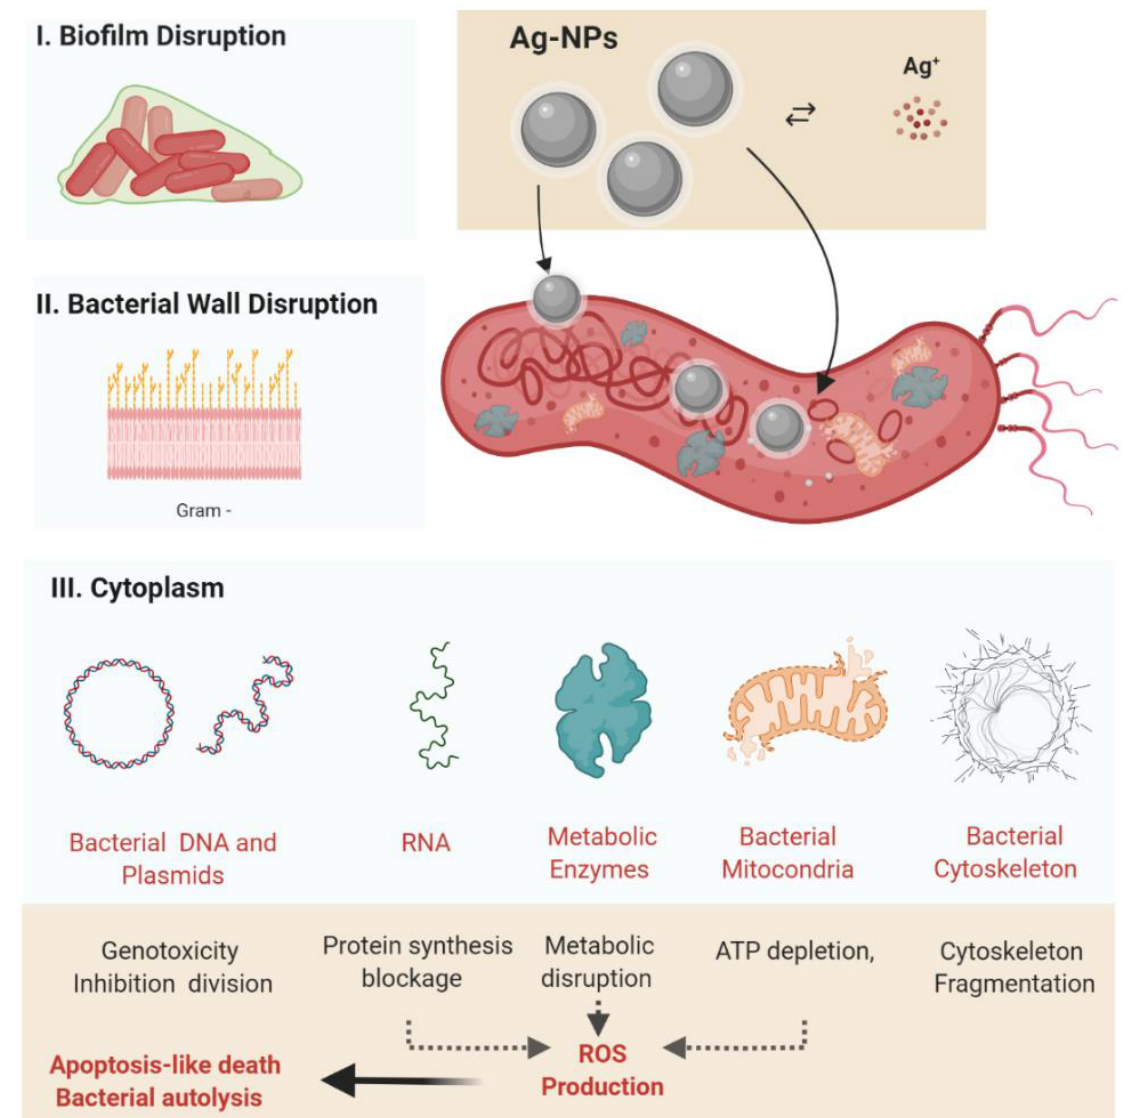
Figure 4. Silver nanoparticles’ antibacterial activity, highlighting the main action mechanisms ( I ). Disruption of the bacterial biofilm ( II ). Adherence of AgNPs to the bacterial cell wall, with bacterial membrane disruption followed by bacterial cytoplasm leakage and electrolytes transport disbalance ( III ). Direct interaction of the AgNPs present within the cytosol with bacterial organelles (mitochondria) and cytoplasmic molecules (including enzymes and the cytoskeleton) followed by metabolic disruption. Abbreviations: AgNPs, silver nanoparticle; ROS, reactive oxygen species: Ag+, silver ions. Created using BioRender (adapted from [117]).